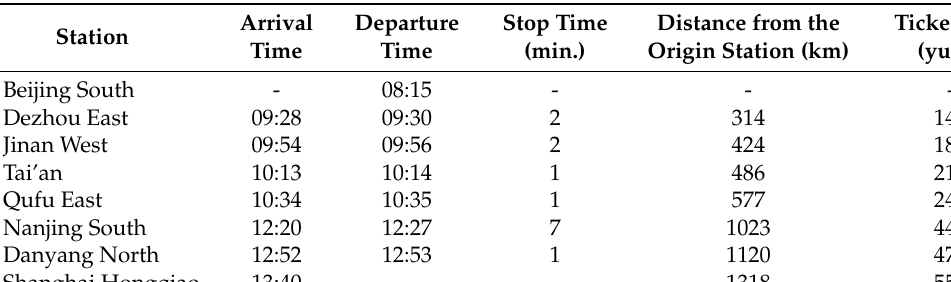
Table 3. Timetable of train route G107 in the Stage 2.